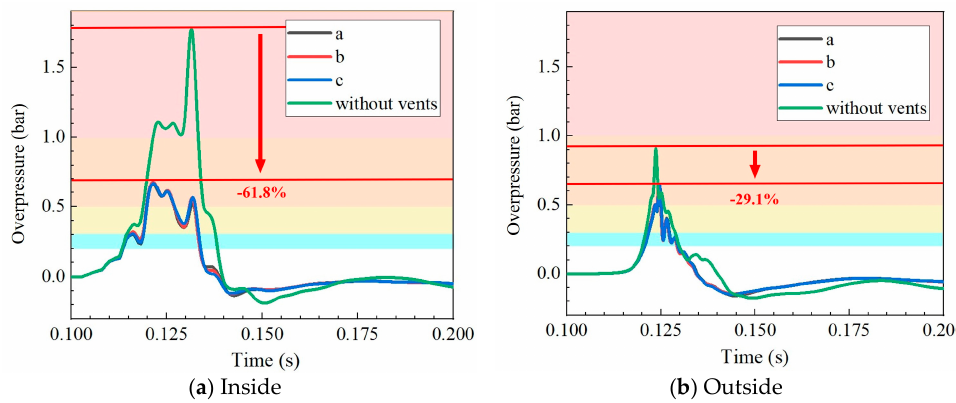
Figure 8. Evolution of the hydrogen overpressures for various explosion vent layouts. (background colors: red-death risk region, orange-serious injury region, yellow-moderate injury region, and blue-slight injury region).